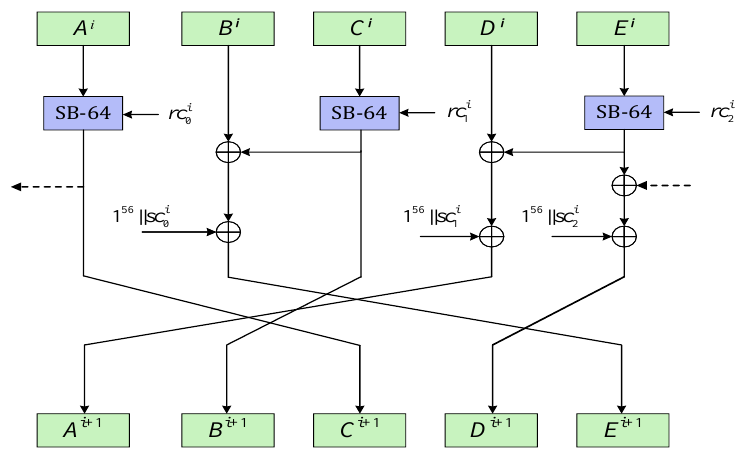
Figure 1. ACE Step Function.